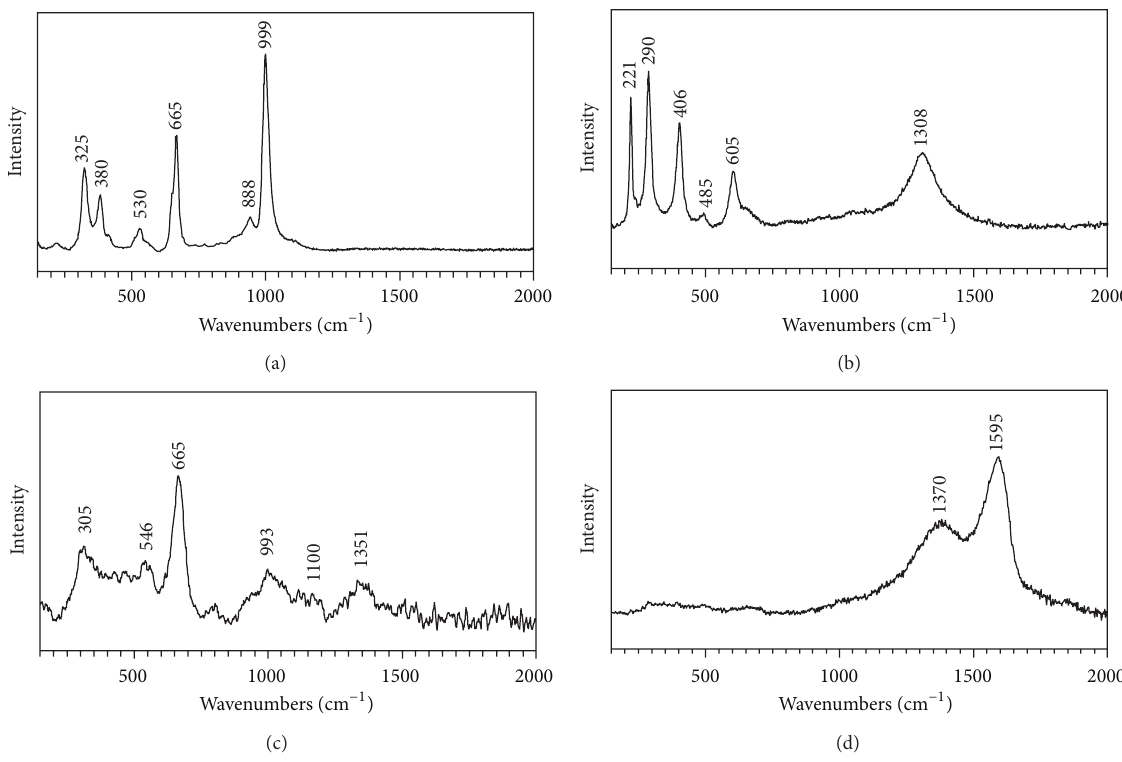
Figure 5: Micro-Raman spectra registered in different spots (see text).